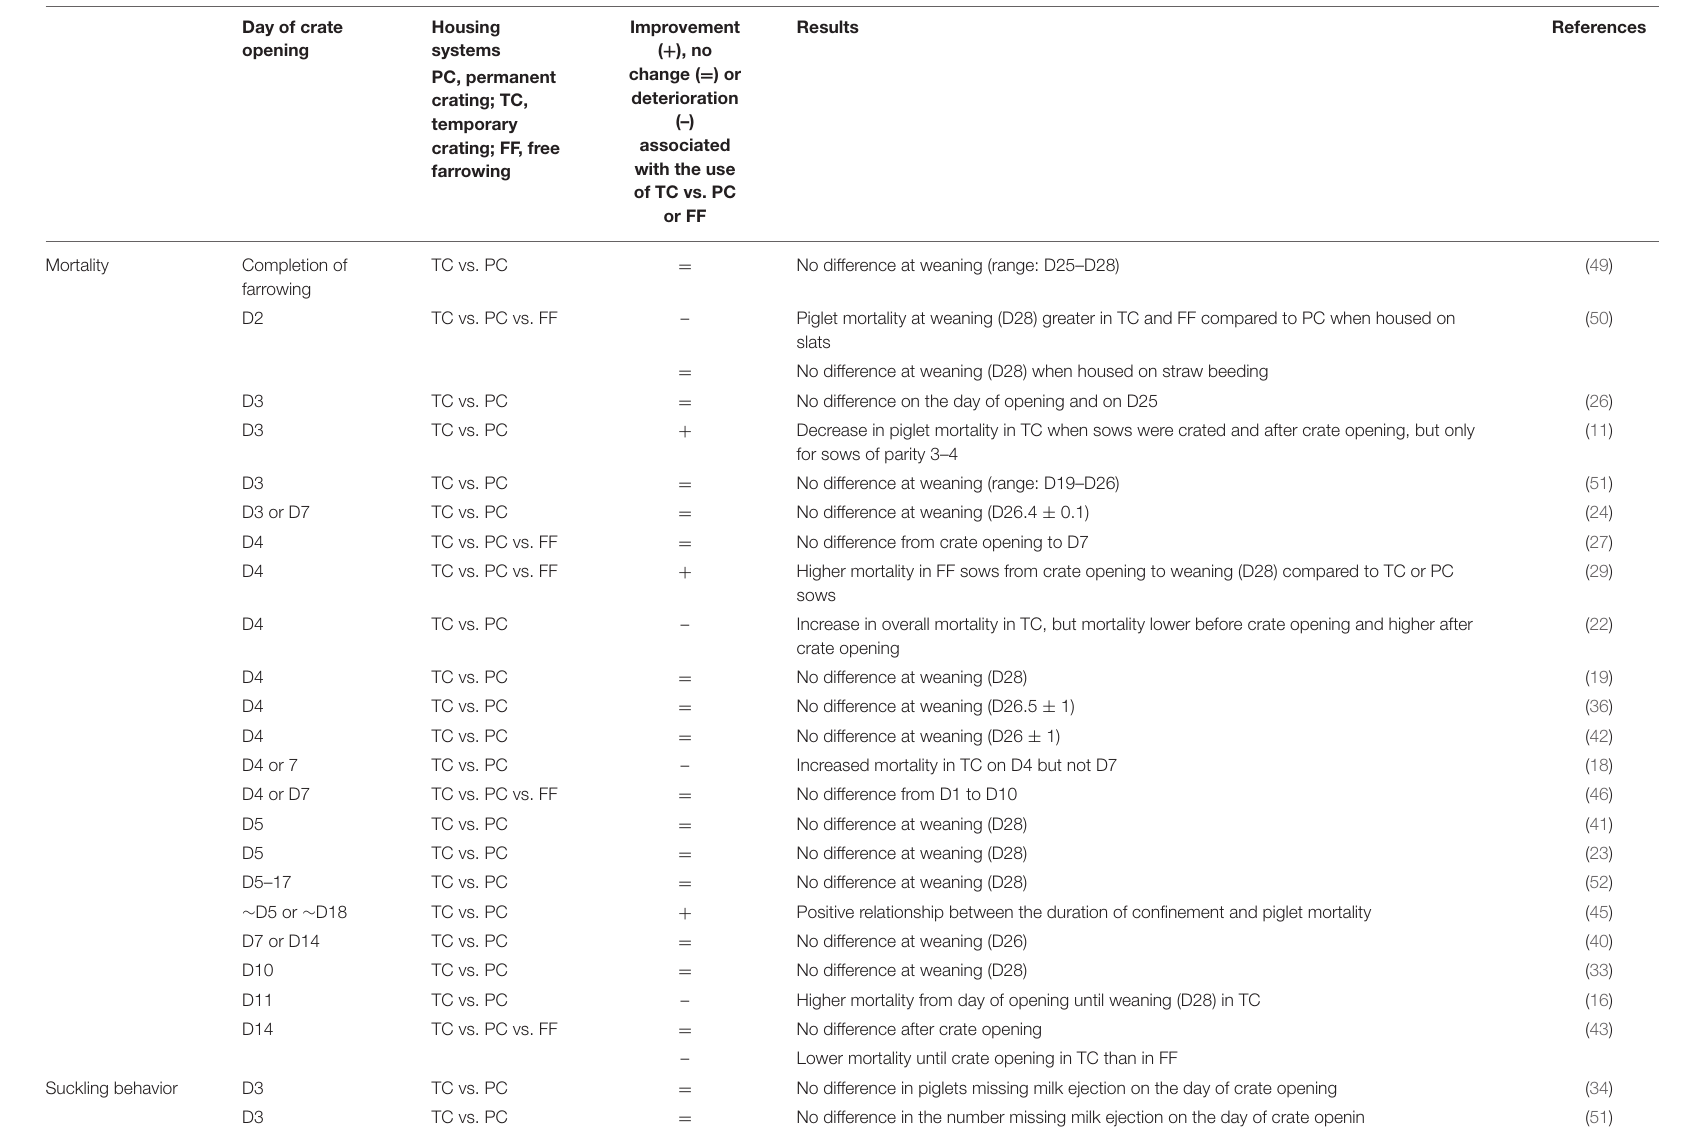
TABLE 4 | Effect of crate opening on piglet